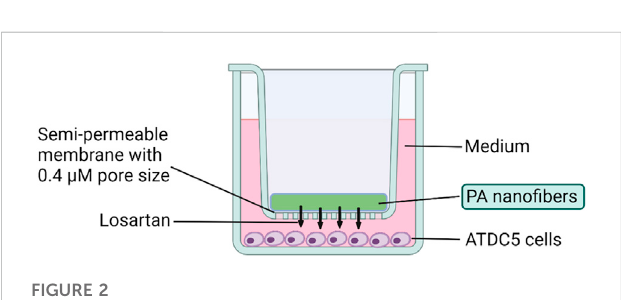
FIGURE 2 Cell culture method using losartan sustained release nano fi bers. TranswellplateswereusedforthecultureofATDC5cells.Chondrocytes were cultured at the bottom of the plate, and each nano fi ber was implanted on a 0.4 μ m semipermeable